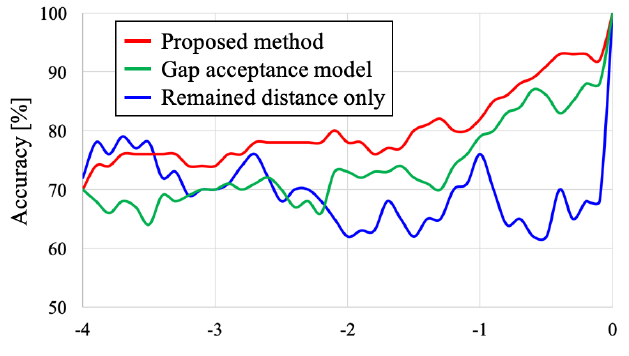
Figure 9. Comparison of accuracy: the red line indicates the accuracy with the proposed method, the blue line represents the method excluding the interaction, and the green line shows the result with GAM. It can be confirmed that the proposed method outperforms the method that does not consider the